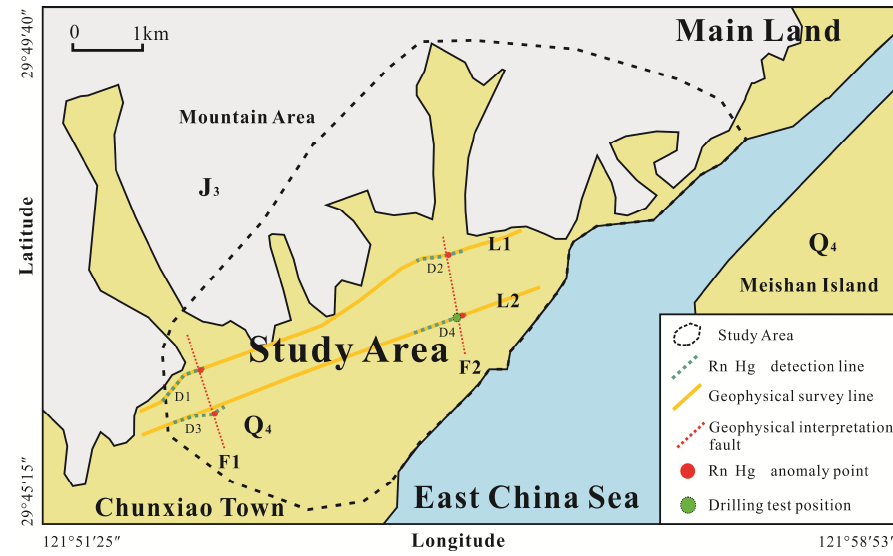
Figure 6. Interpretation of fault location by geophysical methods.